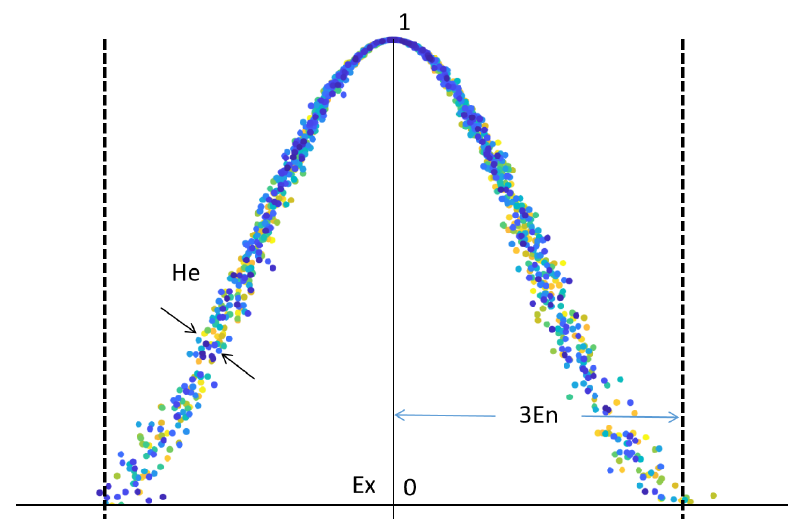
Figure 2. Cloud model diagram.